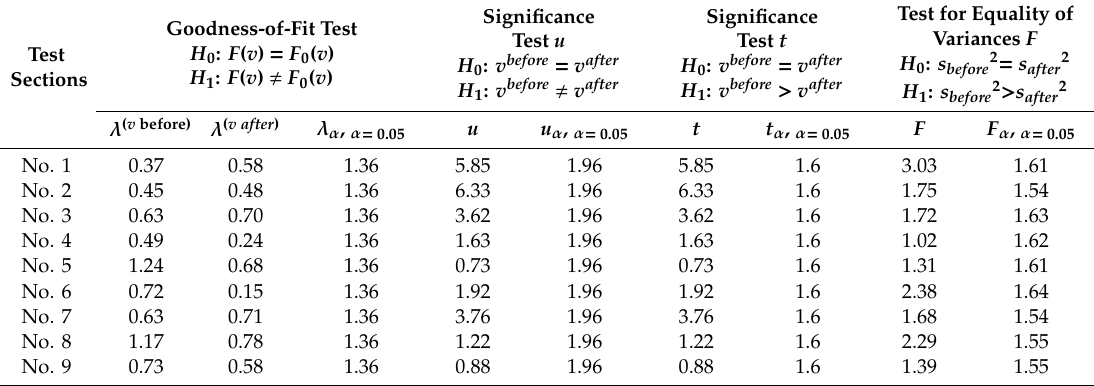
Table A1. Results of standard statistical tests on test sections.